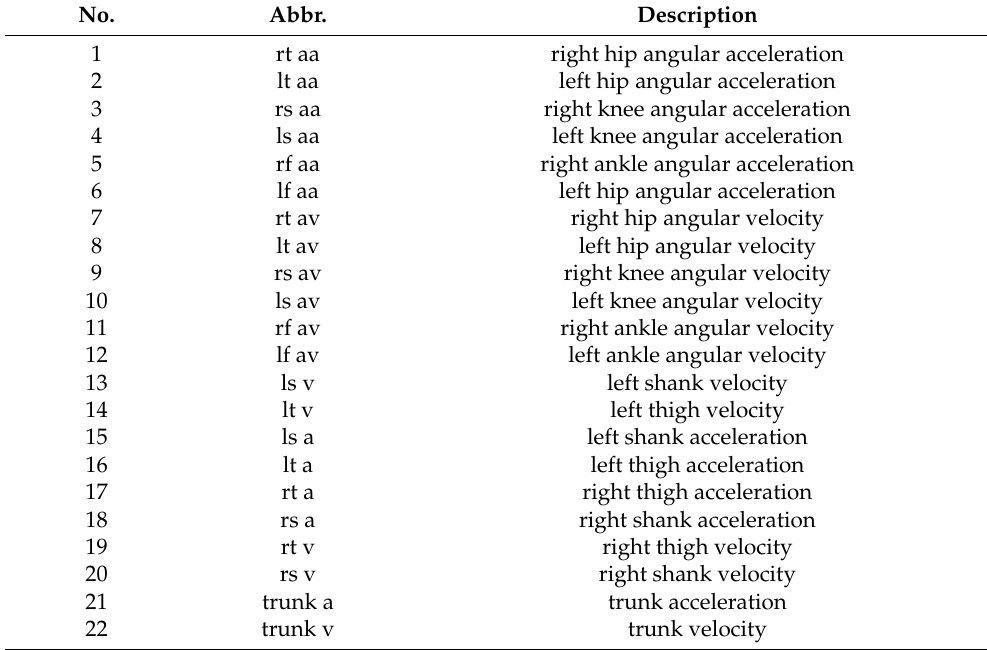
Table 1. Abbreviation and description of kinematic parameters.